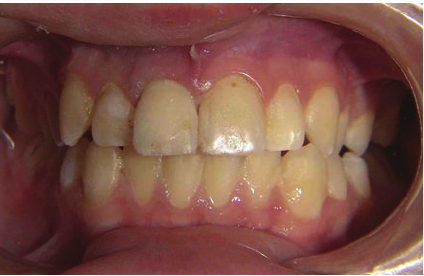
Figure 8: Clinical appearance after the fragment